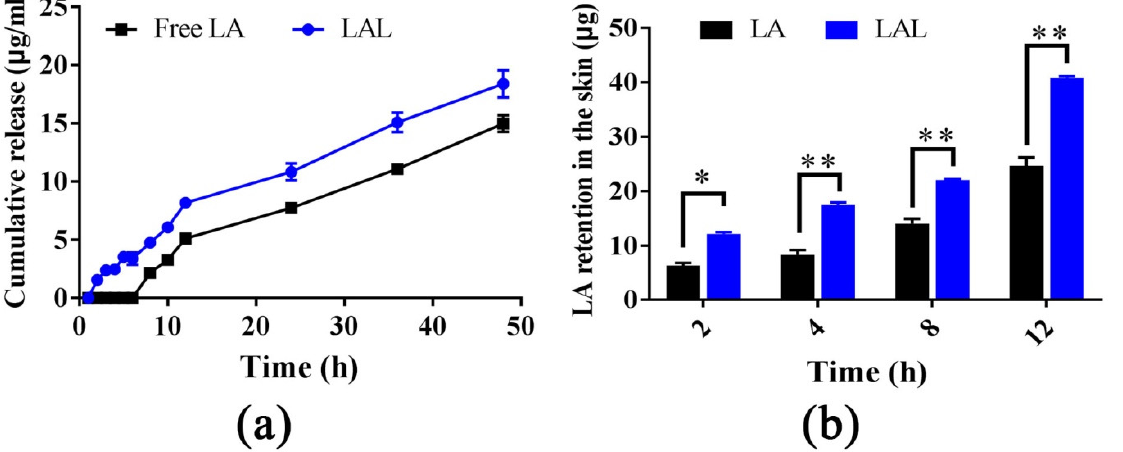
Figure 2. ( a ) The release profile of LA-loaded skin keratin liposomes over48 h ( n = 3); ( b ) the skin retention of LAL nanoparticles and free LA at 2, 4, 8, and 12 h (* p < 0.05, ** p < 0.01 vs. LA, n =